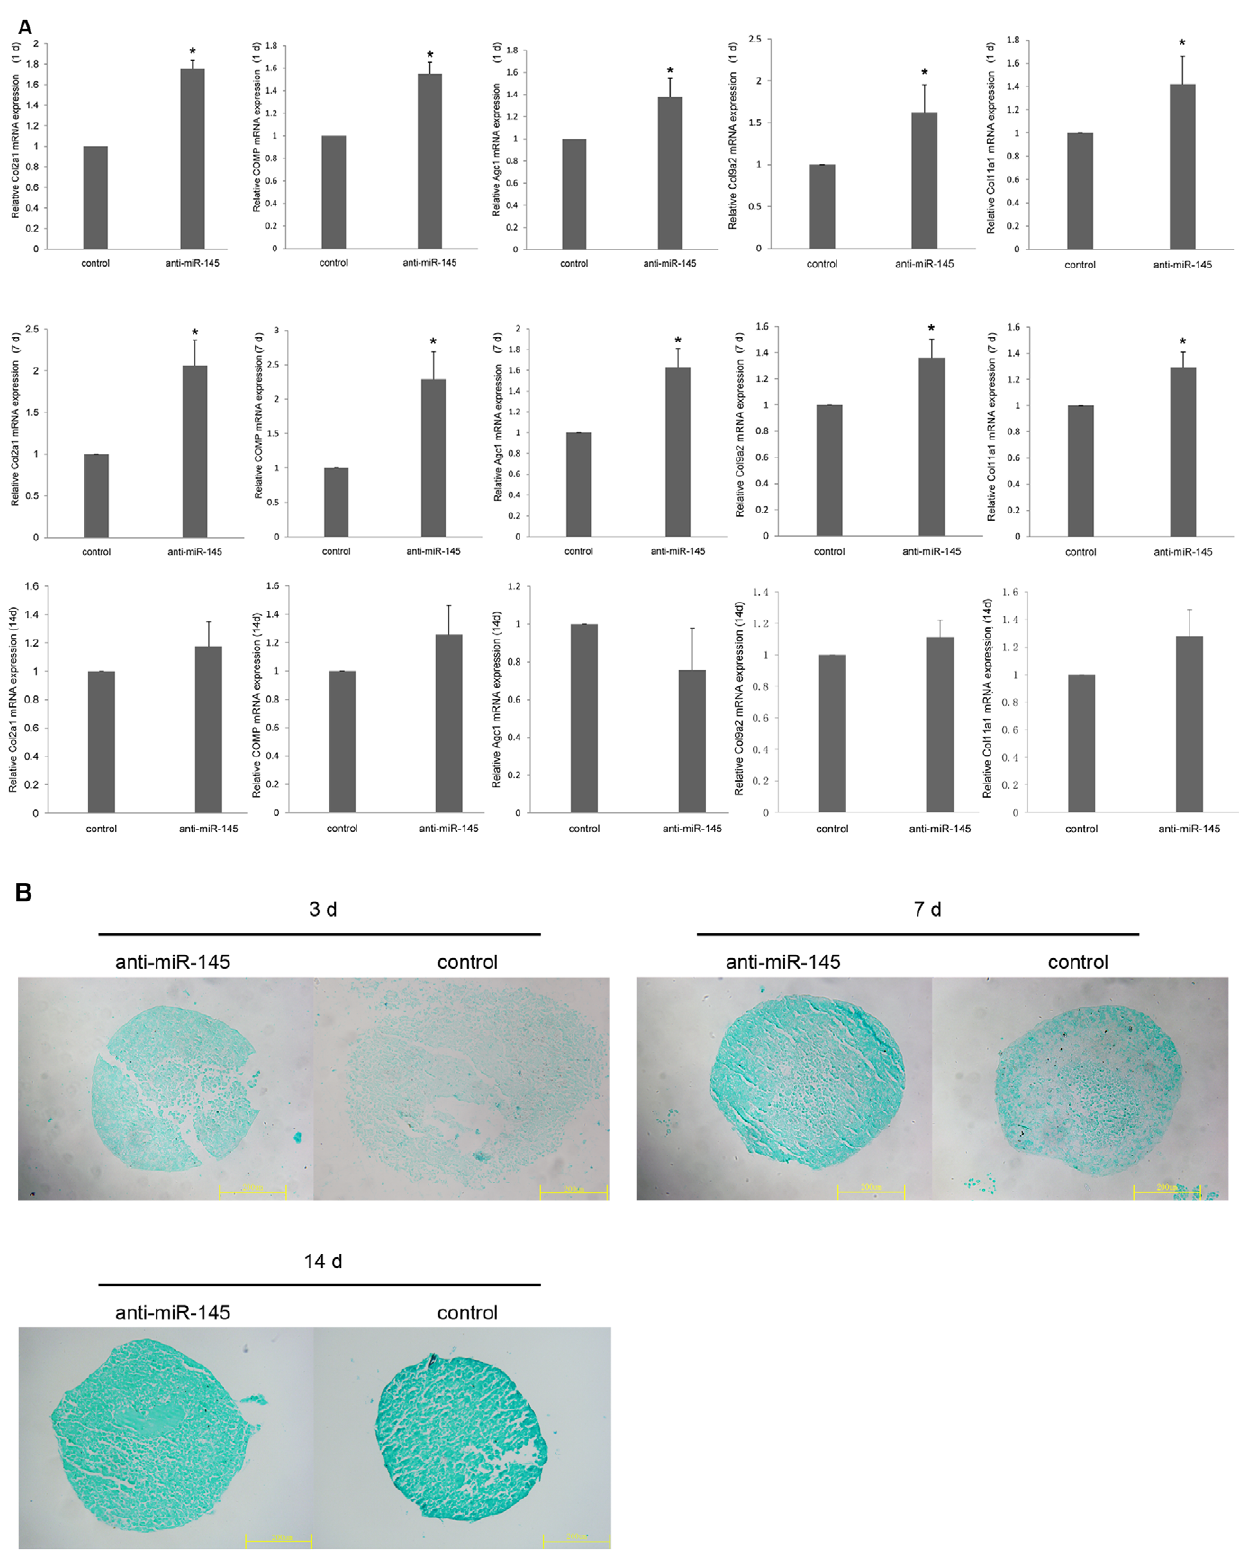
Figure 5. Suppression of mir-145 enhances early chondrogenic differentiation of C3H10T1/2 cells. C3H10T1/2 cells were transfected with anti-miR-145 or its control respectively. (A) After 24 h, 7 d and 14 d of treatment with TGF- b 3, all of cells were lysed and then the expression of chondrogenic differentiation markers, such as Col2a1, COMP, Agc1, Col9a2 and Col11a1, were measured via qRT-PCR. The relative expression level of mRNA in cells transfected with control oligonucleotide was set to one, as control. (B) After 3 d, 7 d and 14d of treatment with TGF- b 3, all of pellets were measured by alcian blue staining. Three independent cell culture experiments were done and data was represented as mean 6 sd. *, p , 0.05, when compared with control.